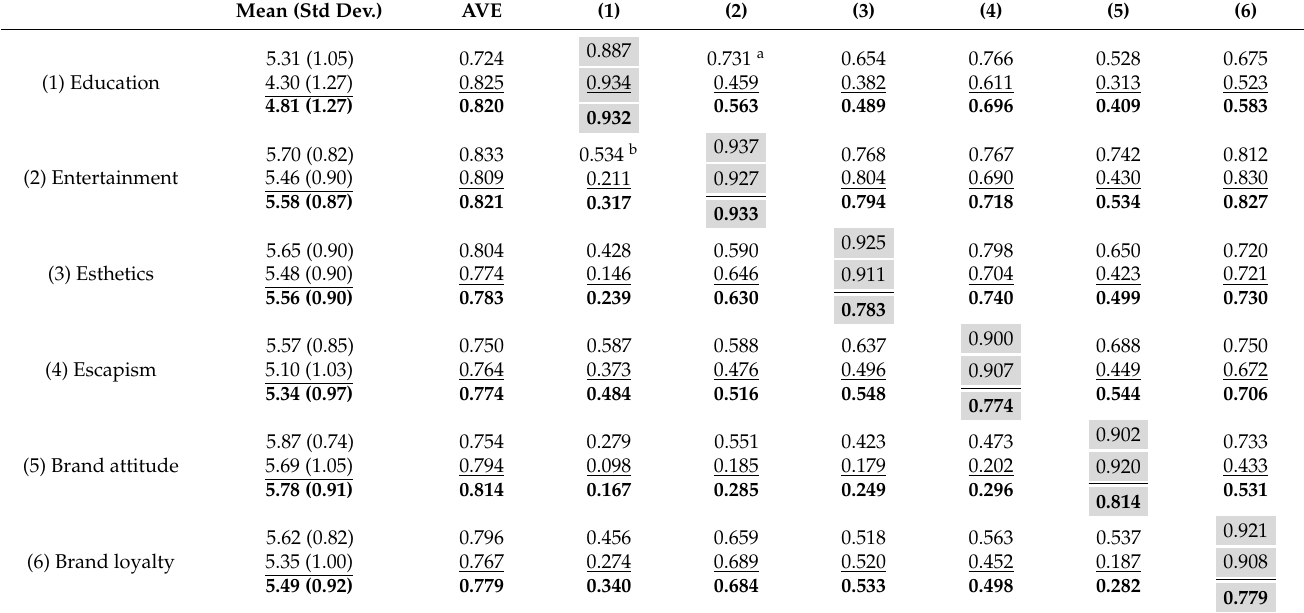
Table 3. Descriptive statistics and associated